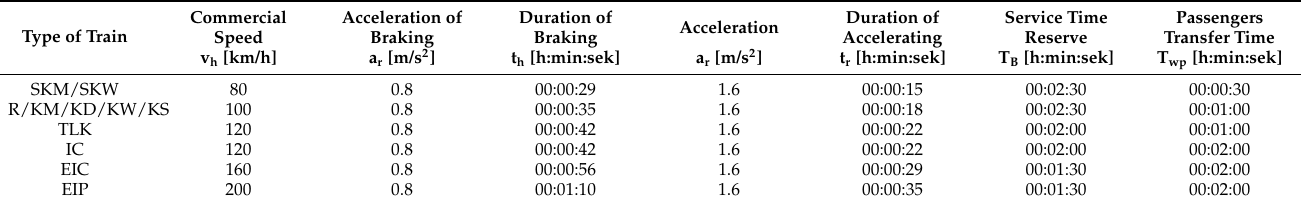
Table 2. Simplified train traction characteristics data and timetable time reserve requirements. Type of